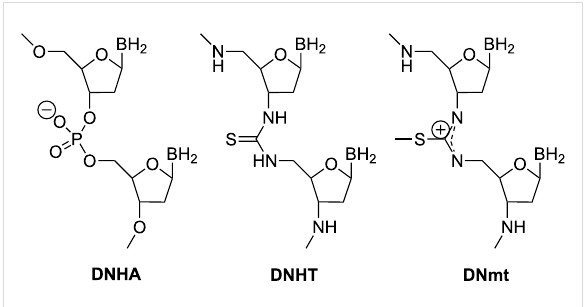
Figure 17: Nucleotide analogues with thiourea and S -methylisothiour- onium linkers.